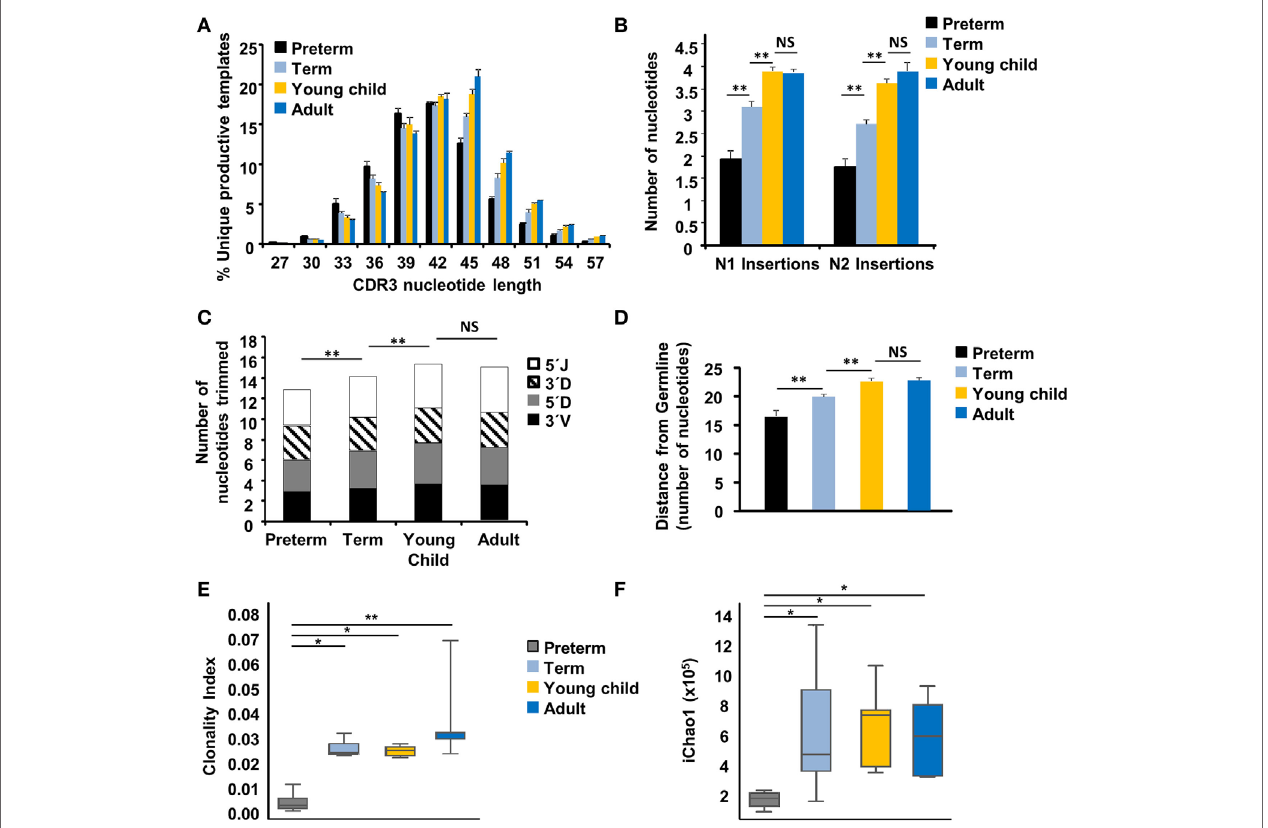
FigUre 3 | The TCR repertoire of naïve CD8 + T cells from preterm neonates is close to germline. (a) The complementarity-determining region 3 (CDR3) sequence frequency (mean ± SEM) for all unique productive templates for the extremely preterm neonates, term neonates, young children and adults is shown. (B) The number of nucleotides (mean ± SEM) inserted into the N1 (region between the V and J gene segments) and N2 (region between the J and D gene segments) are shown. (c) 3 ′ V and 3 ′ D trimming is the nucleotide loss at the 3 ′ of the V and D gene segments, respectively; 5 ′ J and 5 ′ D trimming is the nucleotide loss at the 5 ′ of the J and D gene segments, respectively. (D) Distance from germline is calculated based on the average number of nucleotides ± SEM inserted or trimmed at the gene junctions. The Clonality index (1 − Pielou’s Evenness) (e) and the richness as determined by iChao1 (F) of the naïve repertoire for all four age groups. Shapiro–Wilk test to confirm normal distribution and an unpaired Student’s t -test was performed. * represents < 0.05; ** represents p <